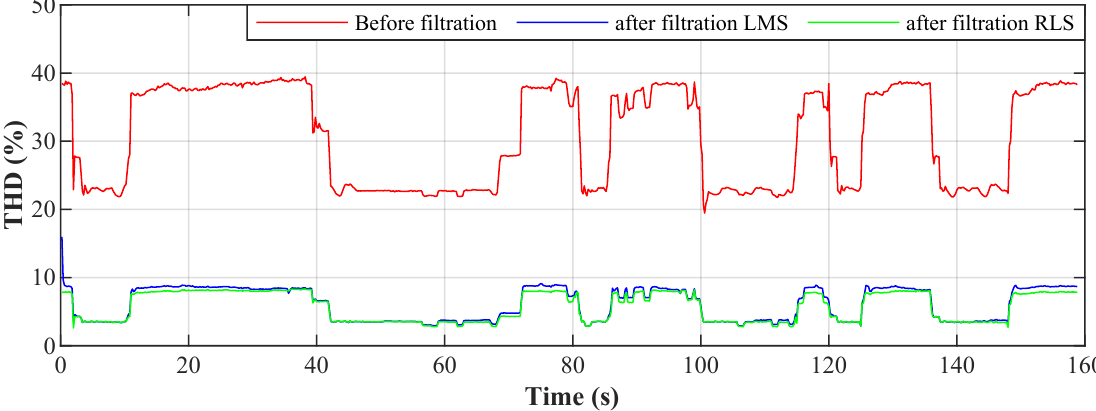
Figure 24. Total Harmonic Distortion (THD) values at intervals of 200 ms.